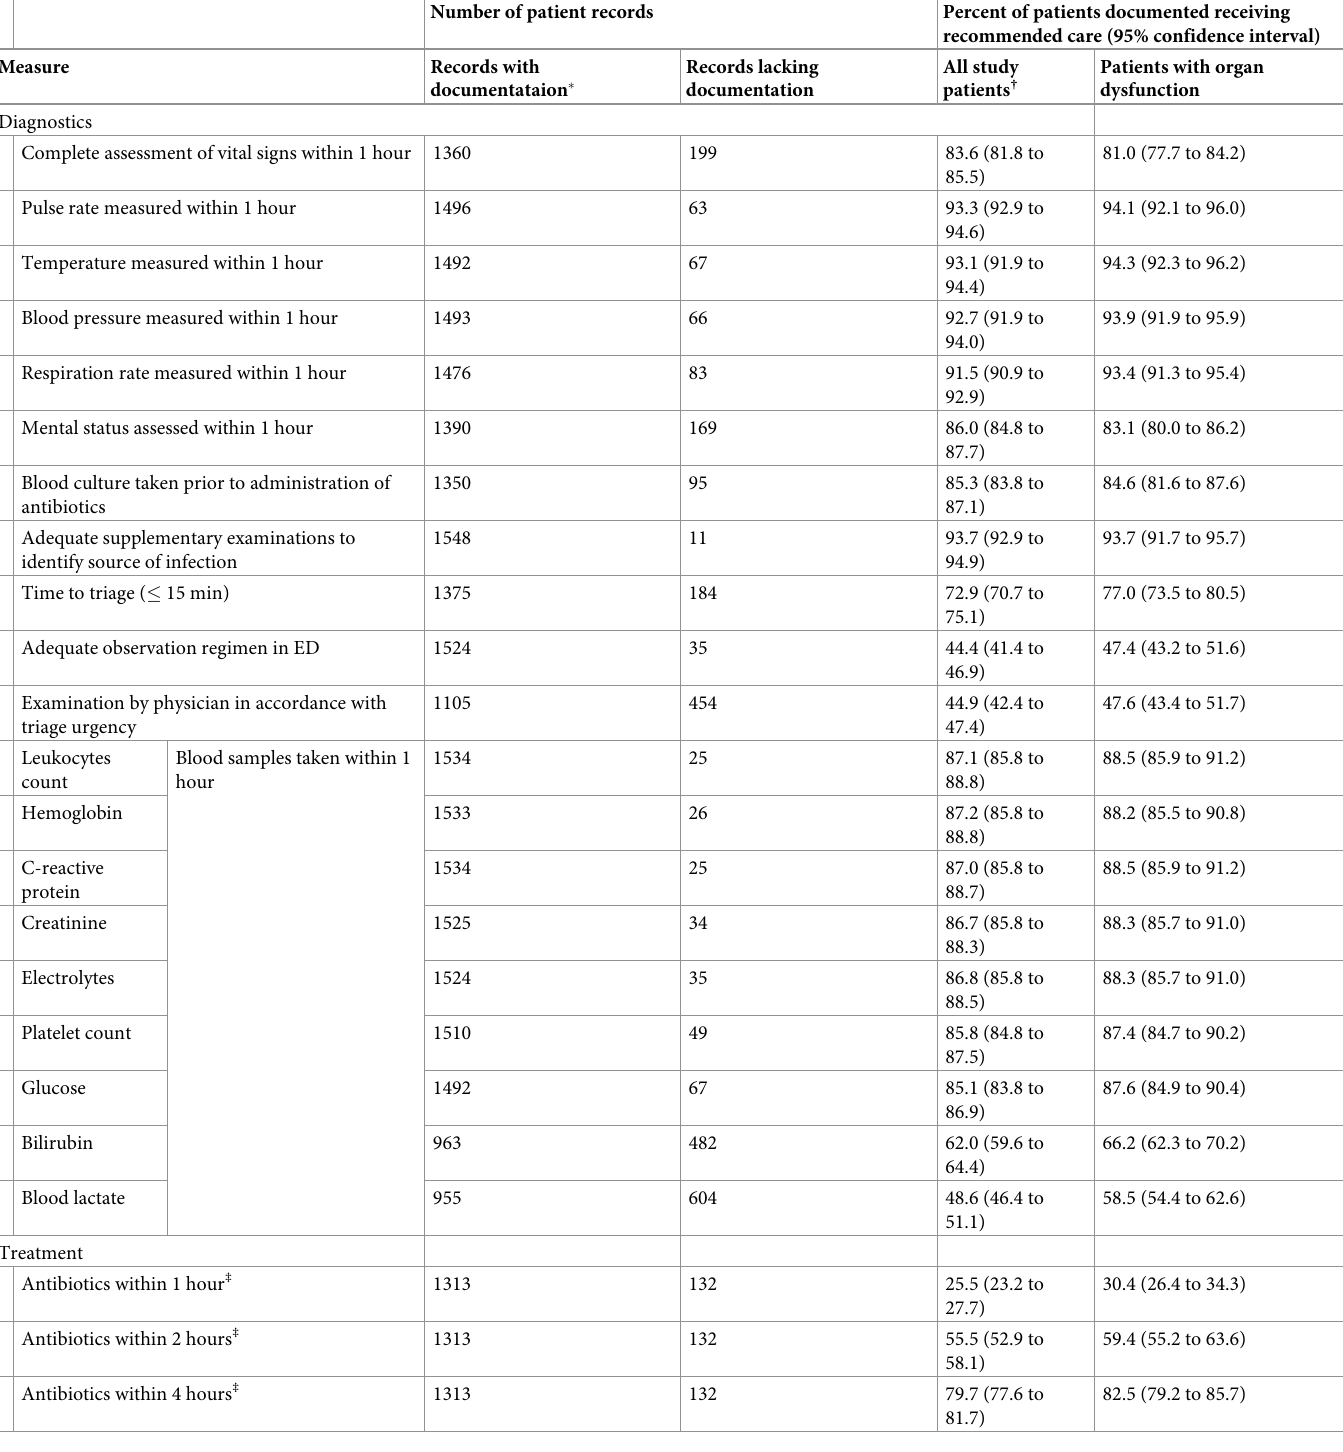
Table 2. Proportion of patients who underwent clinical procedures and received treatment in line with pre-defined